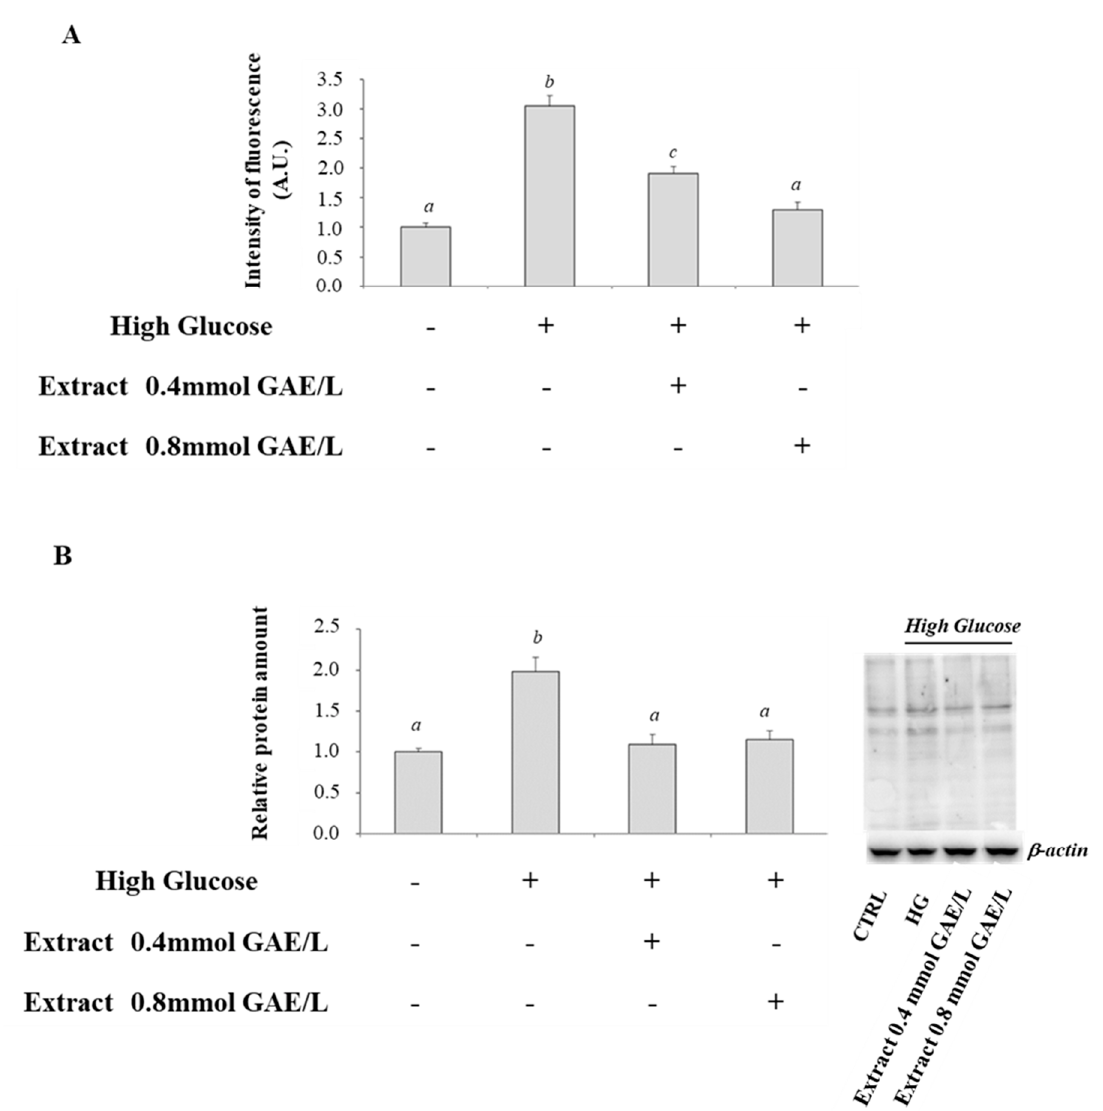
Figure 2. AGEs formation and GA-modified protein in HG-treated CaCo-2 cells in absence and in the presence of apple polyphenolic extract. ( A ) Levels of total fluorescent AGEs and ( B ) Representative western blot of GA-modified proteins and relative densitometric analysis, in control cells (25 mM glucose, Ctrl) or high glucose treated cells (50mM glucose) incubated in the absence (HG) or in the presence of apple polyphenolic extract (0.4 and 0.8 mmol GAE / L). Densitometric data are normalized on β -actin. Results are presented as mean ± SD of 5 determinations carried out in triplicate. Di ff erent letters a–c indicate significant statistic di ff erences between samples ( p <